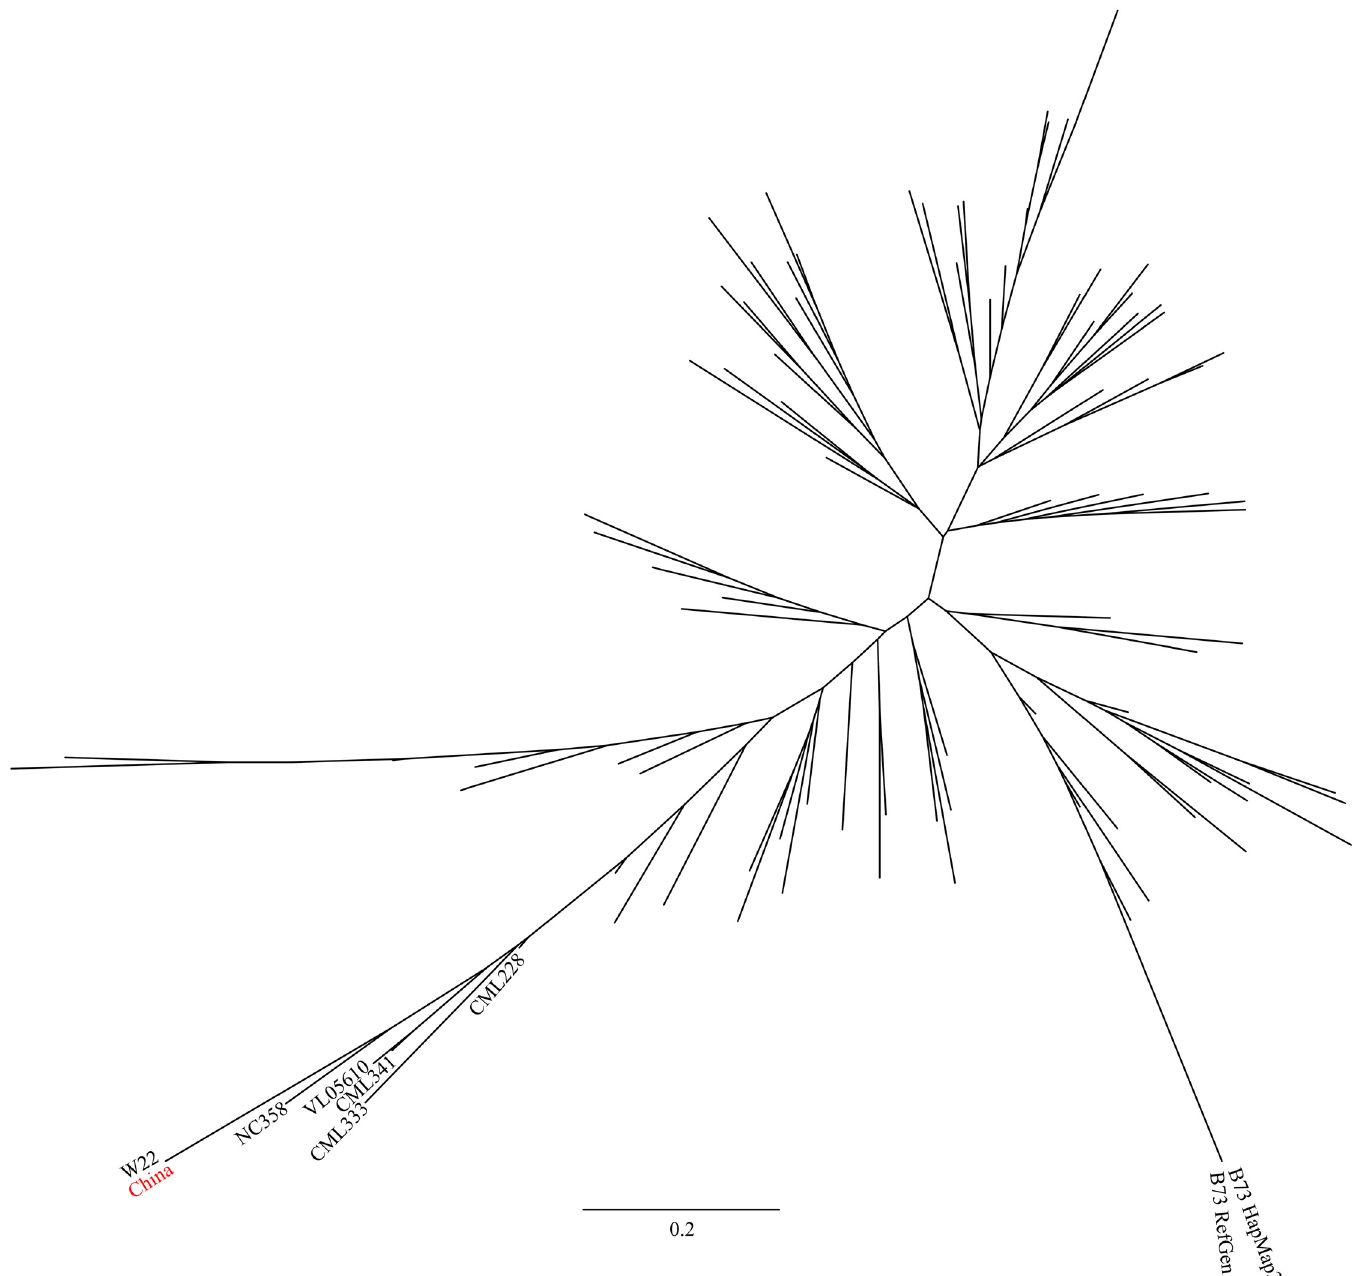
Fig 4. Relationship of the China B73 version of haplotype region c2r1 to the maize HapMap2